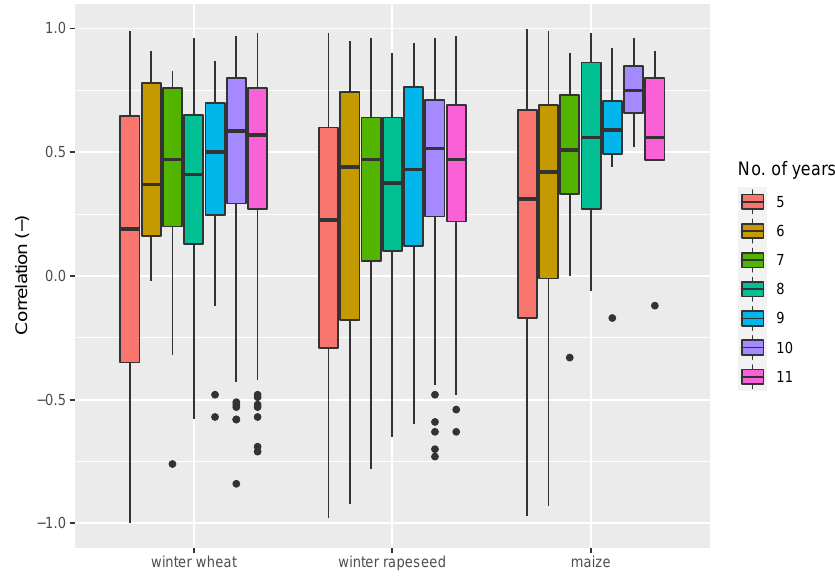
Figure 15. Correlation coefficient ( r ) between reference crop yield statistics (used to train the models) and crop yield forecast as a function of the available time span in years (color